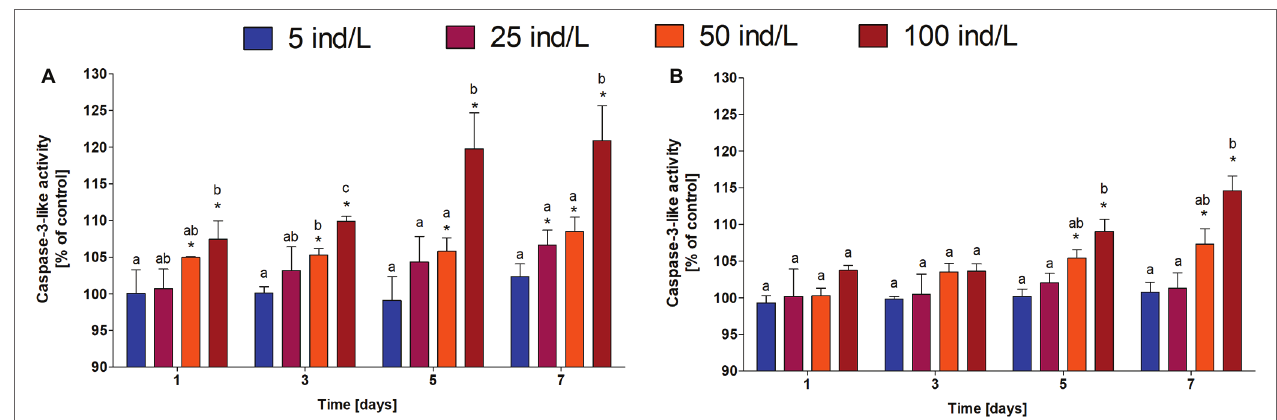
FIGURE 4 | The caspase-3-like activity (mean and SD), a marker of PCD, in M. aeruginosa exposed for 7 days to different concentrations of D. magna (A) and D. cucullata (B) ( n = 5). Different letters indicate statistically significant differences between studied groups for each time interval ( p < 0.05; post-hoc Dunn’s test following Kruskal-Wallis ANOVA).